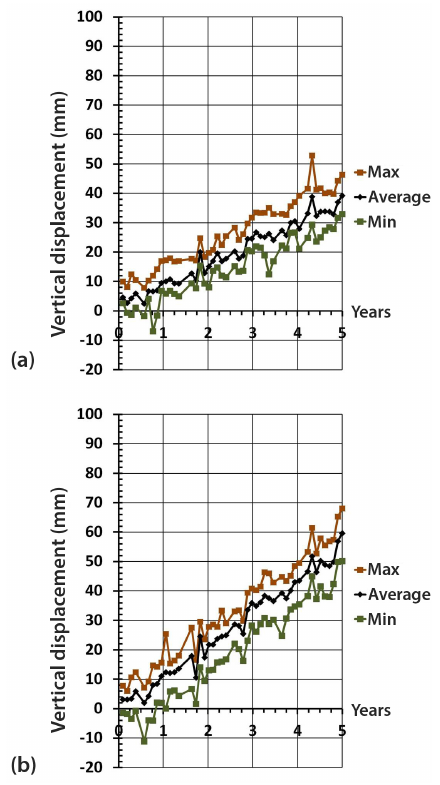
Figure 10. Evolution of subsidence over 5-year time zone in the first observation period (from mid-August 1992 through mid- August 1997): (a) 10 reflectors around coordinates 51.036 ◦ N, 5.375 ◦ E (location Max RES SUBS ); (b) 10 reflectors around coor- dinates 51.022 ◦ N, 5.377 ◦ E (location Max UPLIFT ).